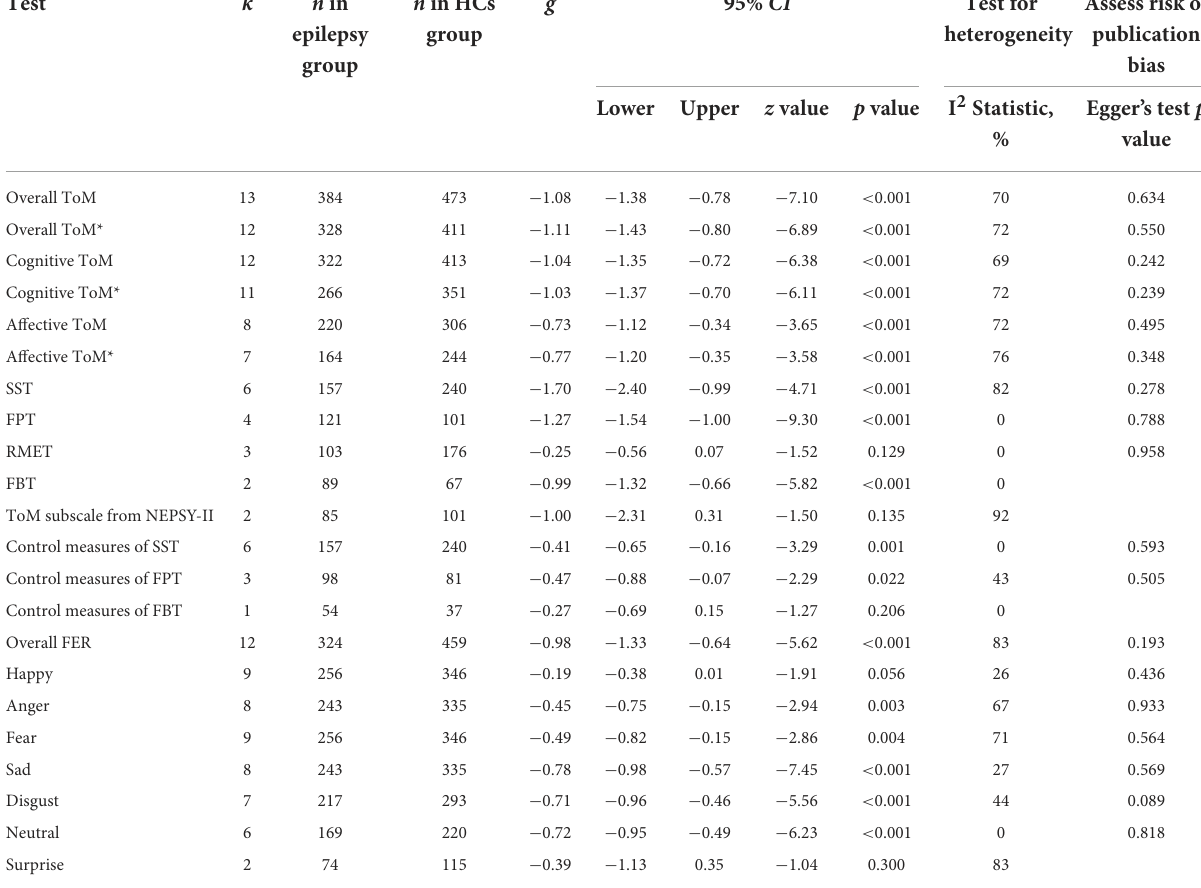
TABLE 3 Mean effects for ToM and FER subcomponents comparing children and adolescents with epilepsy against healthy controls and tests for publication